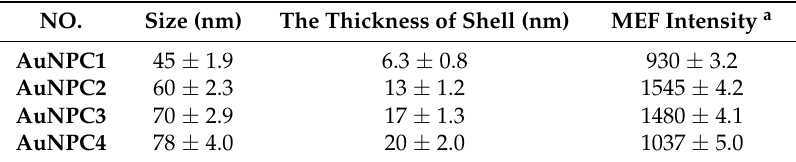
Table 2. The conditions and results for the preparation of the